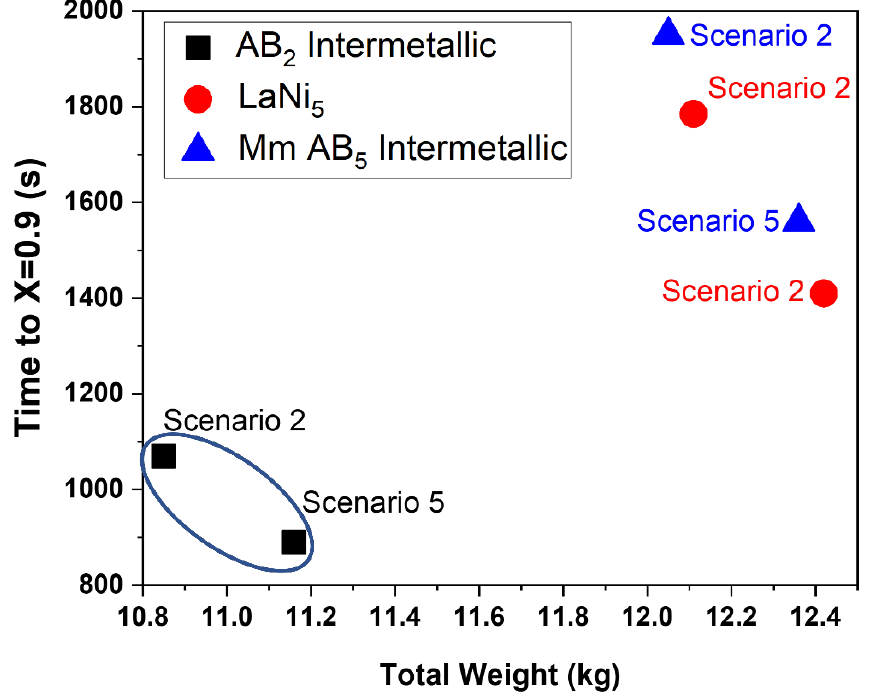
Figure 5. Comparison of the hydrogenation time and the total weight the system for Scenario 2 and 5.